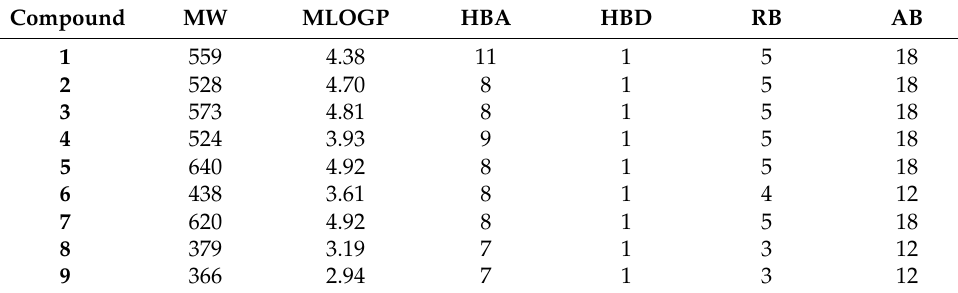
Table 7. Molecular properties of coumarinyl Schiff bases.